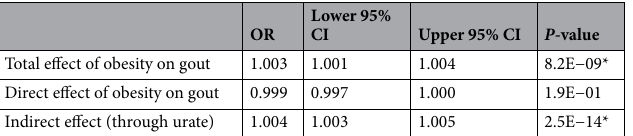
Table 4. Total, direct, and indirect effects of obesity on gout, with urate as the mediator. OR: odds ratio; CI: confidence interval.